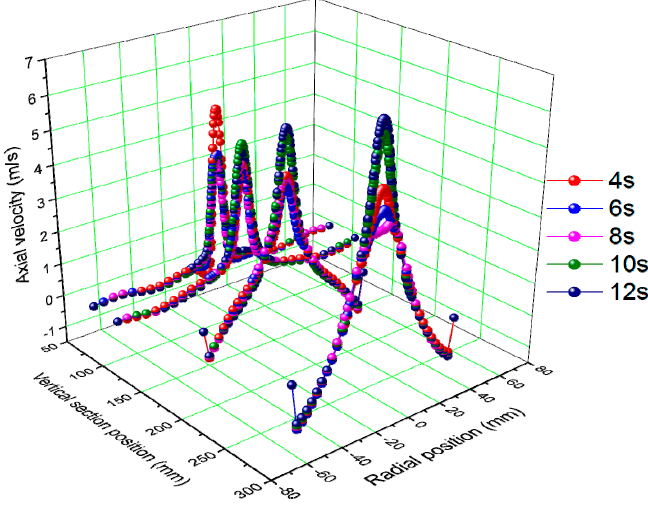
Figure 15. Distribution curve of axial velocity.